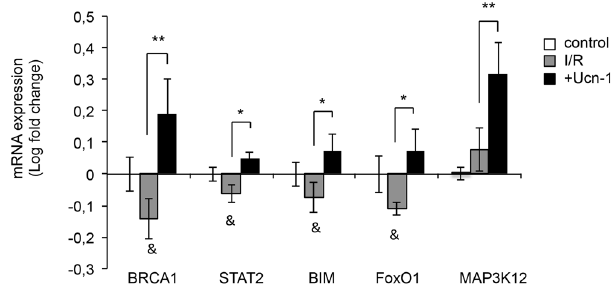
Figure 7. Urocortin-1 regulates the expression of BRCA1, STAT2, BIM, FoxO1 and MAP3K12 in isolated cardiac myocytes under I/R. Bar graphs show rate changes of genes’ mRNA expression assessed by qRT-PCR in adult rat cardiac myocytes (control); in untreated cells undergoing I/R protocols myocytes ( I/R ); and in cells treated with Ucn-1 in I/R (10 nM, + Ucn1 ). Values are in logarithmic scale normalized to control and are means ± S.E.M (n = 8). “ * ” and “ ** ” indicate significance at p < 0.05 and p < 0.01, respectively. “&” indicates significance between I/R and control at p <